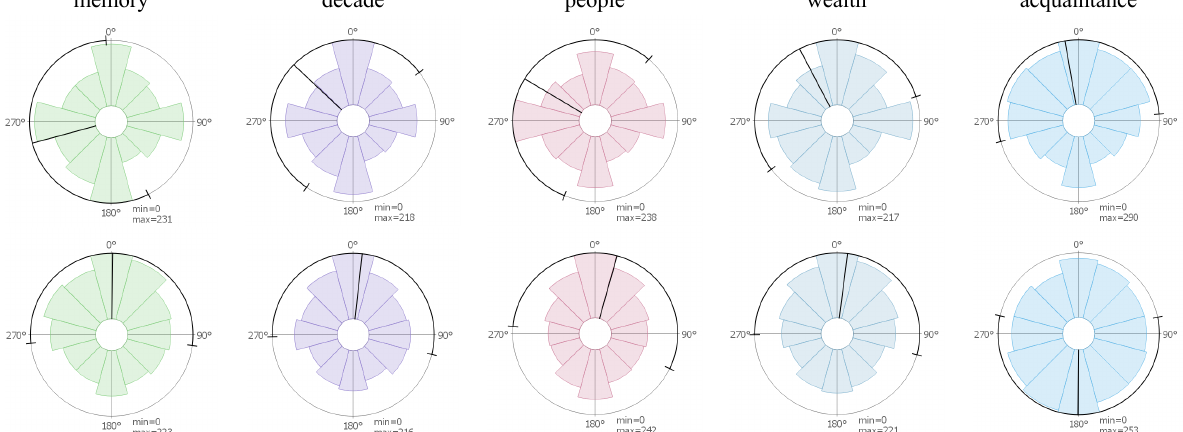
Figure 7. Rose plots for microsaccade distributions for the 4 different tasks of the photo data set ( memory , decade , people , and wealth ) and the painting data set ( acquaintance ). First row: directions of microsaccades in screen coordinates as visible on the stimulus. Second row: microsaccade directions in local coordinates: they are rotated in such a way that 0° means that a microsaccade is in the direction to the next fixation. Min and max specify the values in the middle of the plot and on the circle, respectively; values are measured in microsaccade